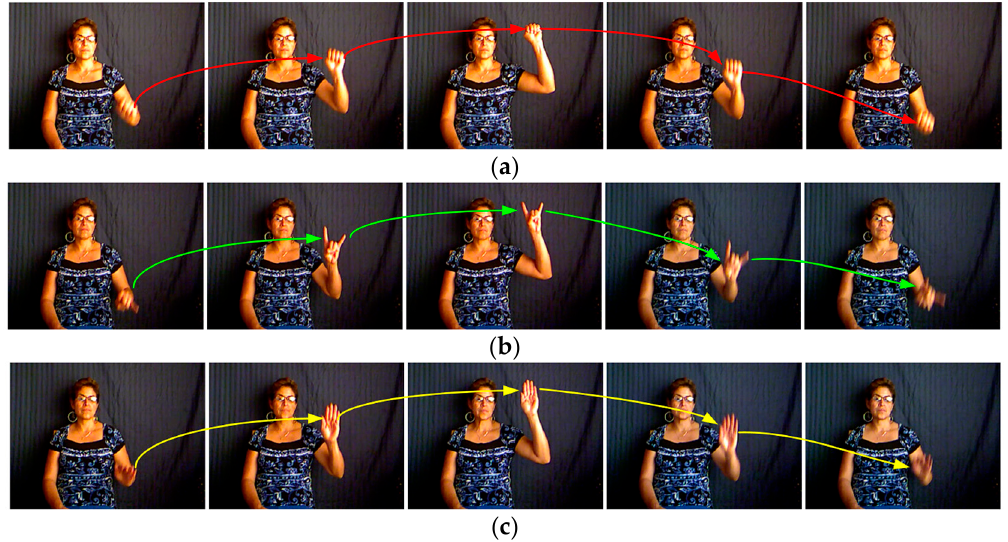
Figure 9. ( a – c ) Three gestures that have similar trajectories (color curves) but different hand shapes and appearances. Each column shows one stage of these gestures from the start frame to the last frame.